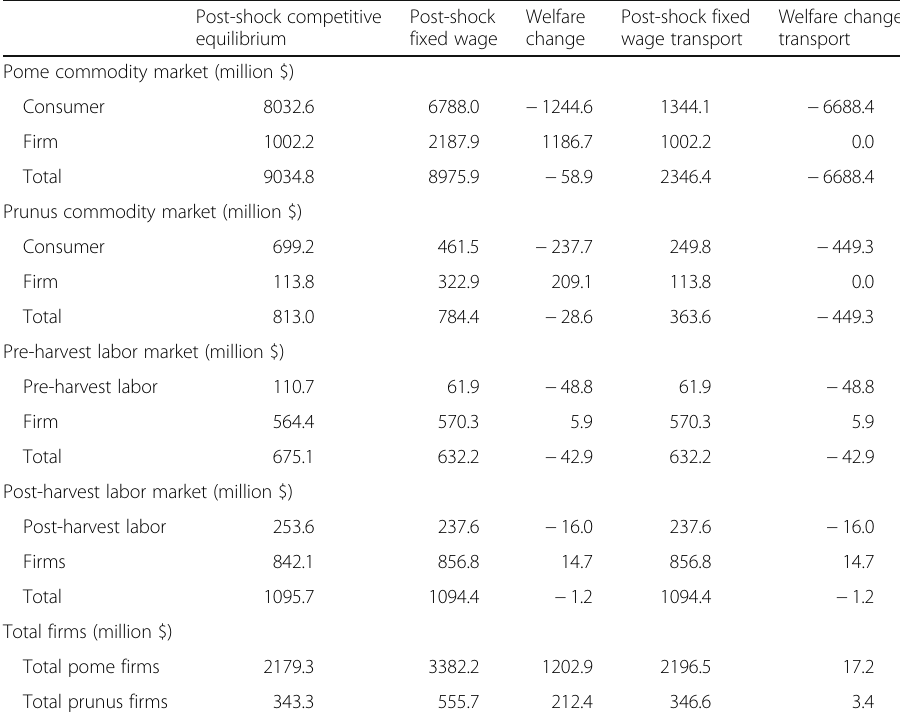
Table 7 Economic